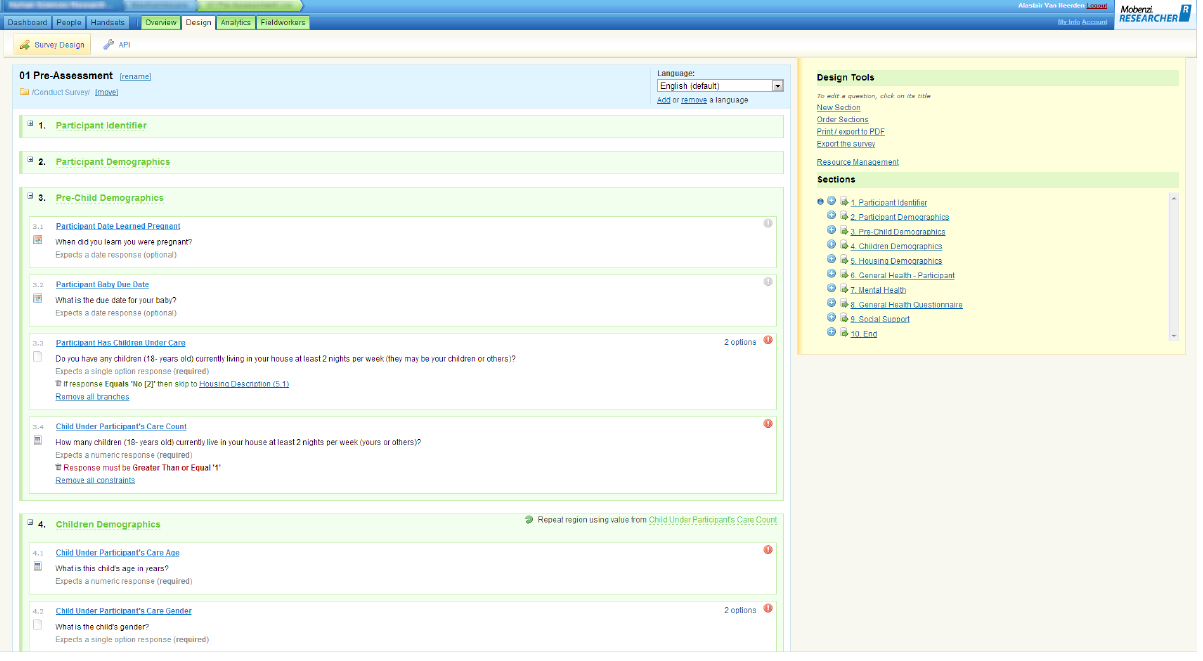
Figure 2. Example of Mobenzi Researcher Web portal: survey